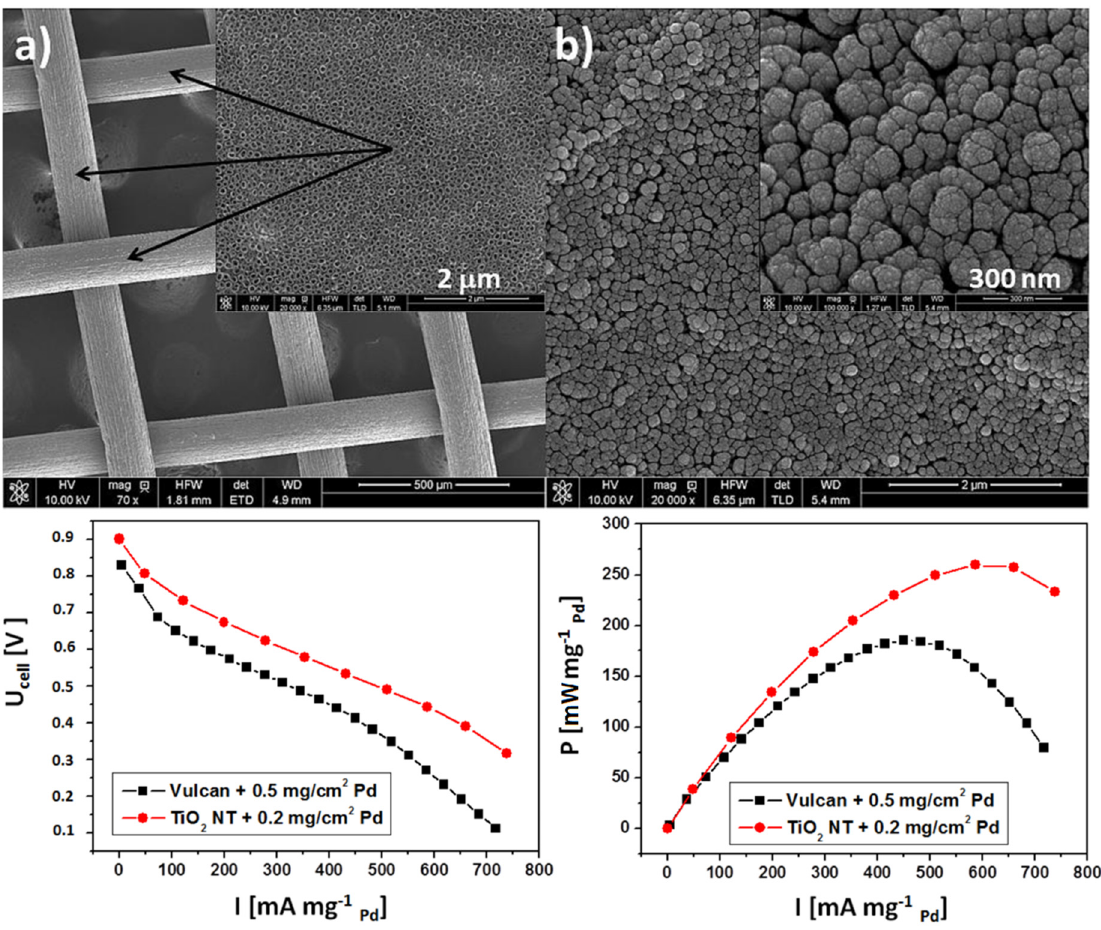
Figure 4. SEM images of a TiO 2 -NT formed ( a ) at 25 V on Ti mesh and annealed at 450 °C for 1 h and ( b ) covered with a Pd deposit (0.2 mg·cm − 2 ). Comparison of the voltage ( U cell ) and power (P) as functions of specific current for electrooxidation of 3 M HCOOH by using Pd/Vulcan or Pd/TiO 2 -NT as the anode. Figure adapted from [58] .